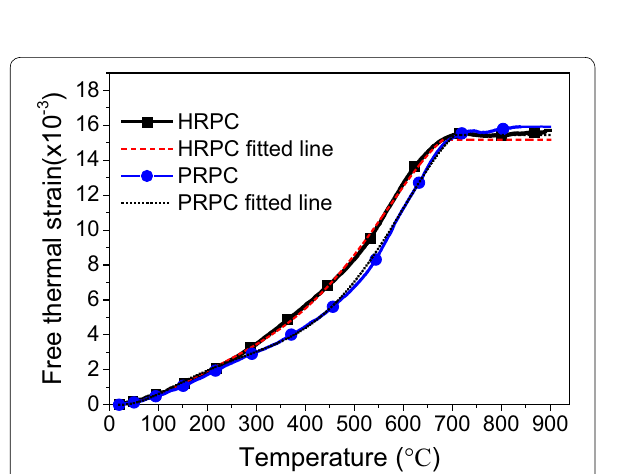
Fig. 11 FTS of HRPC and